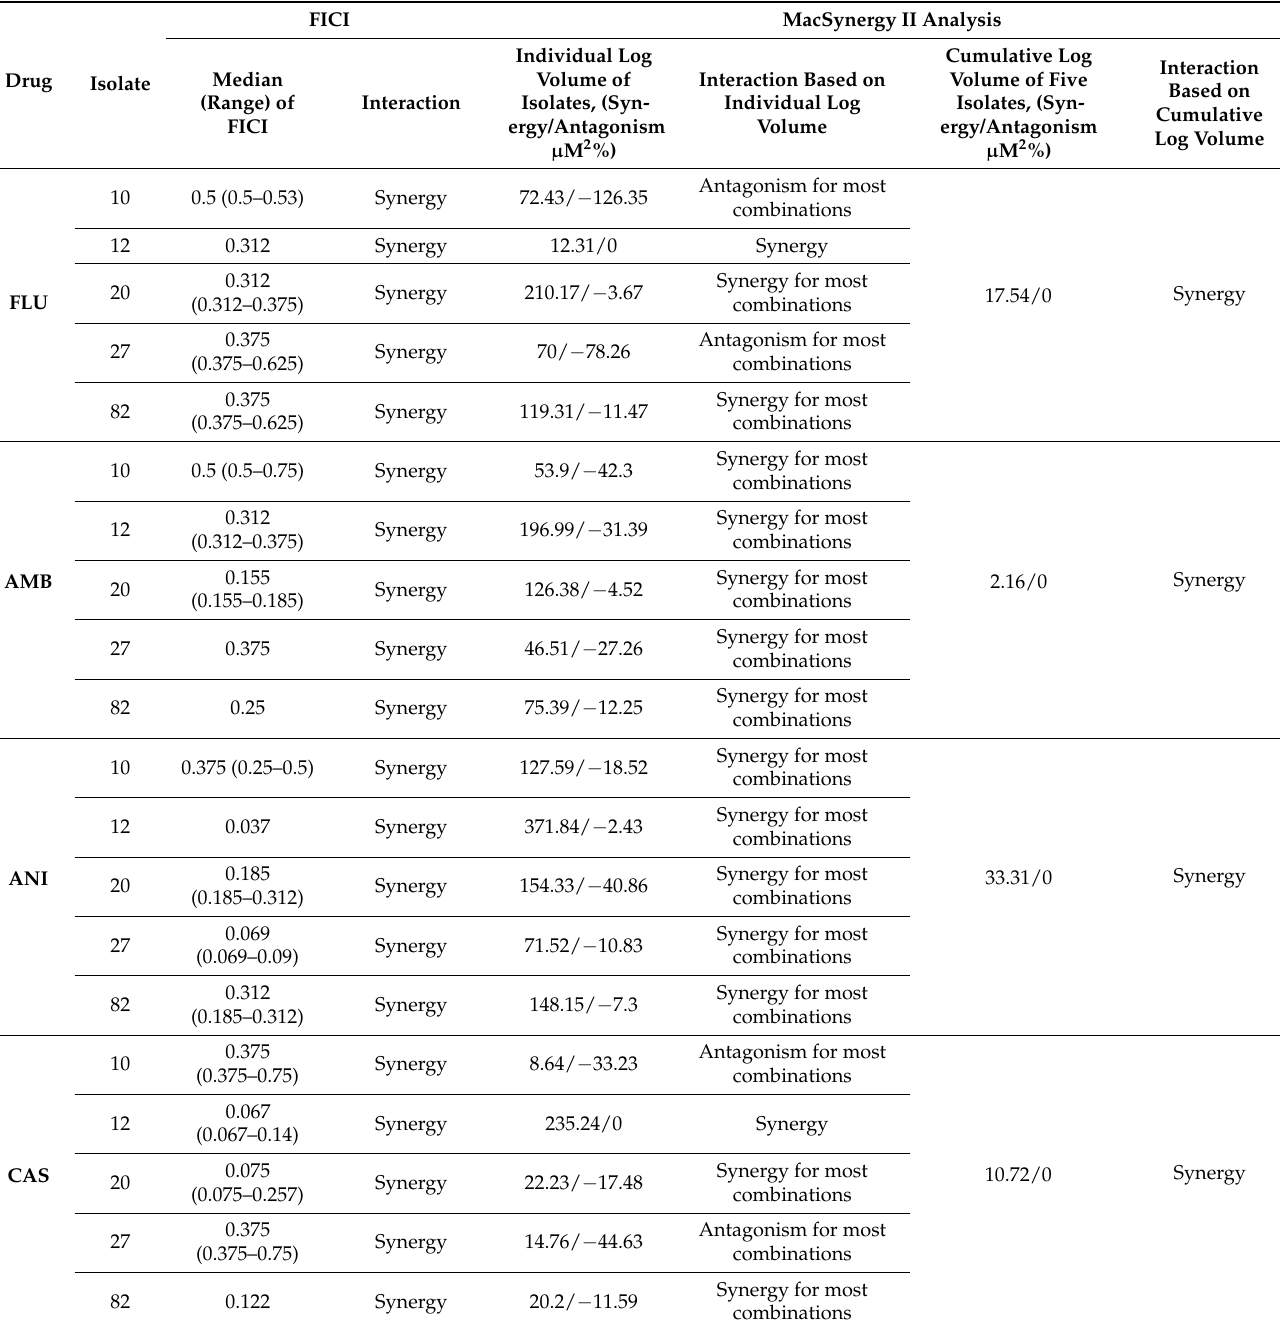
Table 2. In vitro interactions by Fractional Inhibitory Concentration Indexes (FICI) and MacSynergy II analysis of fluconazole (FLU), amphotericin B (AMB), anidulafungin (ANI), caspofungin (CAS) and micafungin (MICA) in combination with Neosartorya fischeri antifungal protein 2 (NFAP2) against C. auris biofilms.